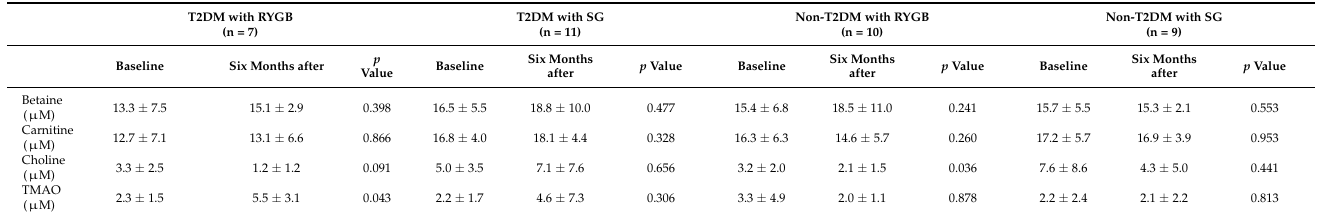
Table 5. Changes in metabolites according to diabetes and surgery